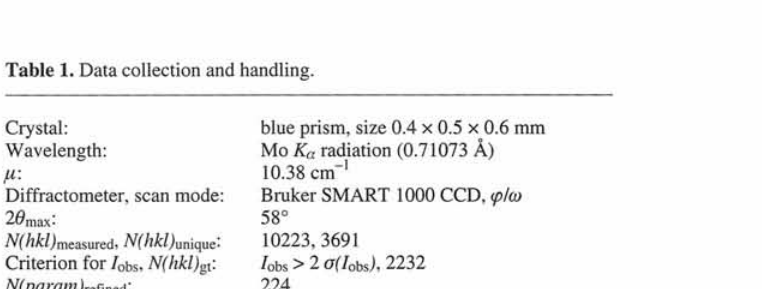
Table 1. Data collection and